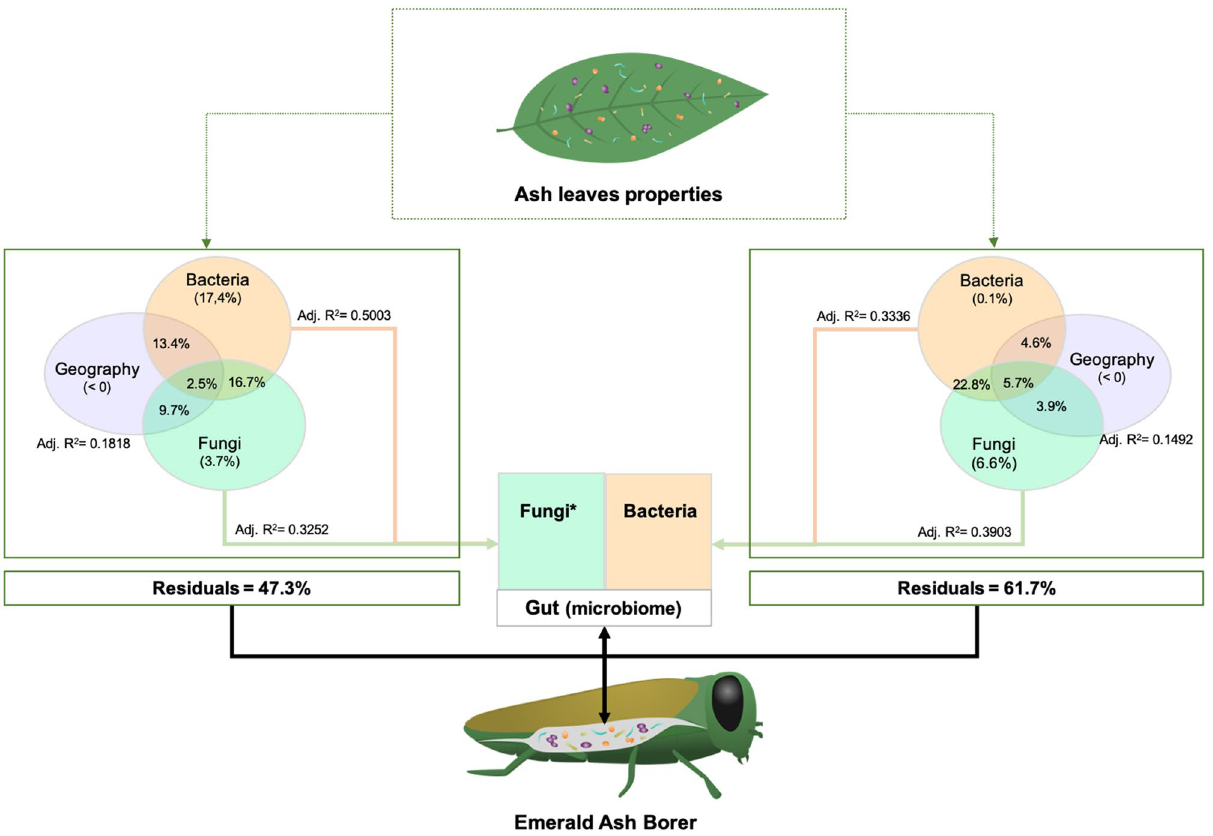
Figure 6. Global representation showing variation partitioning analysis of microbial communities associated with leaves on the microbial communities associated with adult EAB gut. The host tree descriptors that have been found as explanatory matrices (bacteria, fungi, and geographic coordinates) are represented on the left portion (for the variation of the EAB gut fungal community), and on the right portion (for the variation of